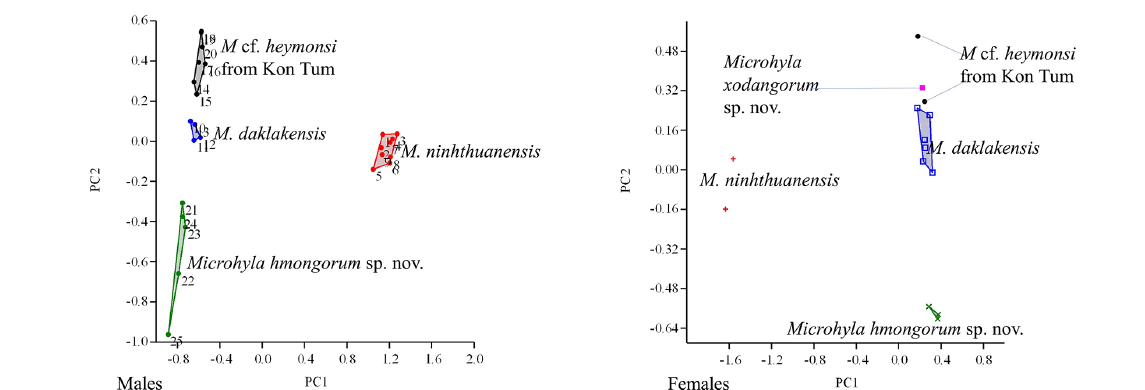
Fig. 1. Plots of the first principal component (PC1) versus the second (PC2) for the males and the females of Microhyla hmongorum sp. nov. (green), Microhyla xodangorum sp. nov. (pink), M. ninhthuanensis Hoang et al ., 2021 (red), M. daklakensis Hoang et al ., 2021 (blue), and M. cf. heymonsi Vogt, 1911